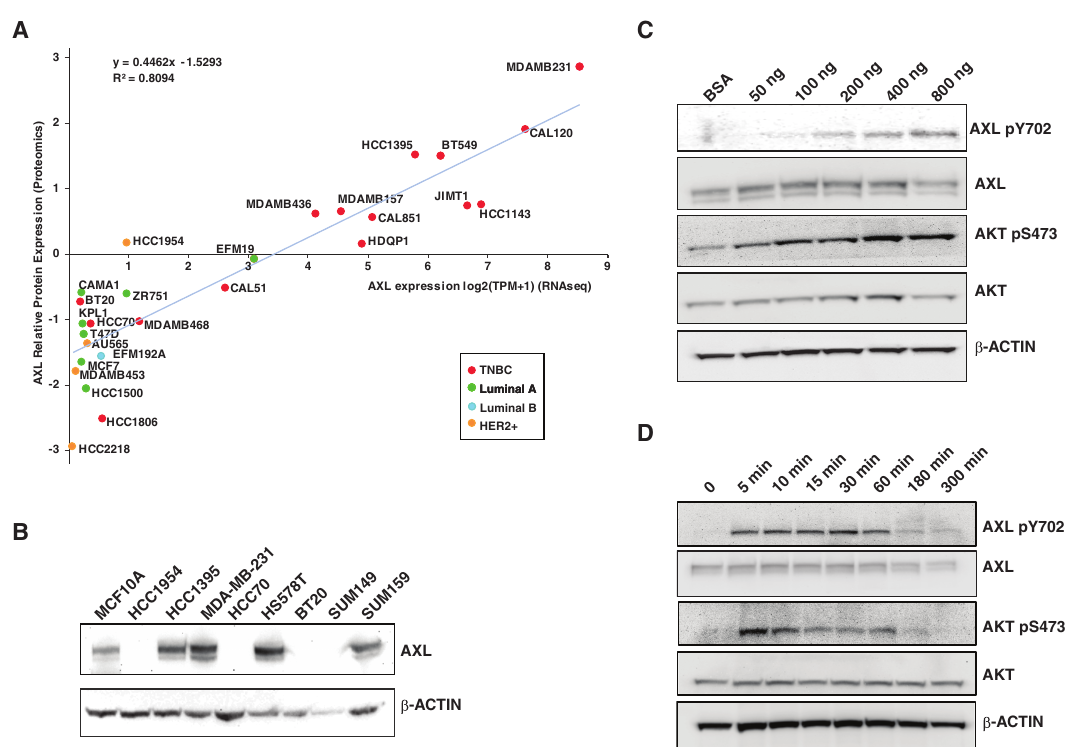
Figure 1. AXL expression and GAS6 stimulation in breast cancer cell lines. ( A ). Scatter plot showing AXL expression levels based on RNA-Seq data and its protein expression based on proteomics data (both from CCLA) as indicated. The color of the dots represents the subtype of breast cancer cell lines: TNBC (red), luminal A (green), luminal B (blue) and HER2+ (yellow). ( B ). Western blot results showing AXL expression level in a panel of nine TNBC cell lines. Beta-actin serves as a loading control. ( C ). MDA-MB-231 cells were treated with the indicated concentration (ng/mL) of GAS6 for 10 min. Phosphorylation levels of AXL and AKT and their total protein expression levels were examined by Western blot analysis. ( D ). MDA-MB-231 cells were treated with 400 ng/mL GAS6 for different time points as indicated. Phosphorylation levels of AXL and AKT and their total protein expression levels were examined by Western blot analysis as shown. (The original western blot images were included in Figure